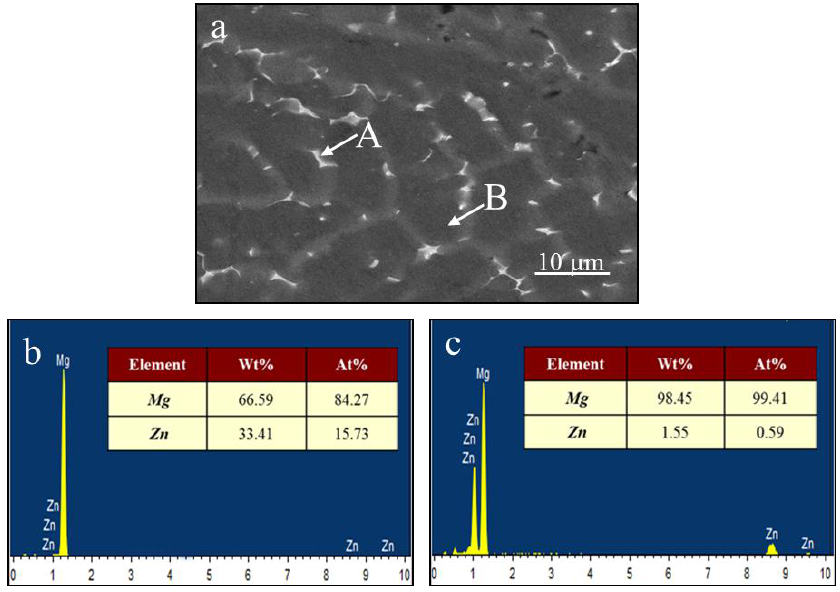
Figure 4. ( a ) SEM of the etched Mg-Zn alloys; ( b ) EDS results of area A in Figure 4a and ( c ) EDS results of area B in Figure 4a.